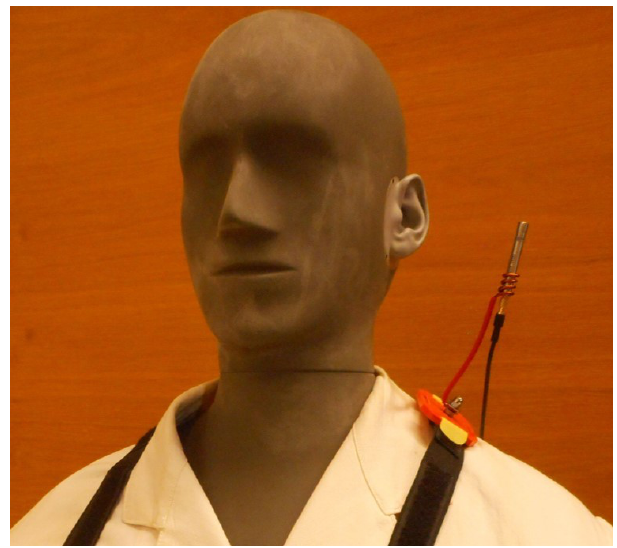
Figure 18. Preliminary placement location for the HiFUSPEx microphone located on the artificial head’s shoulder with a rudimentary microphone